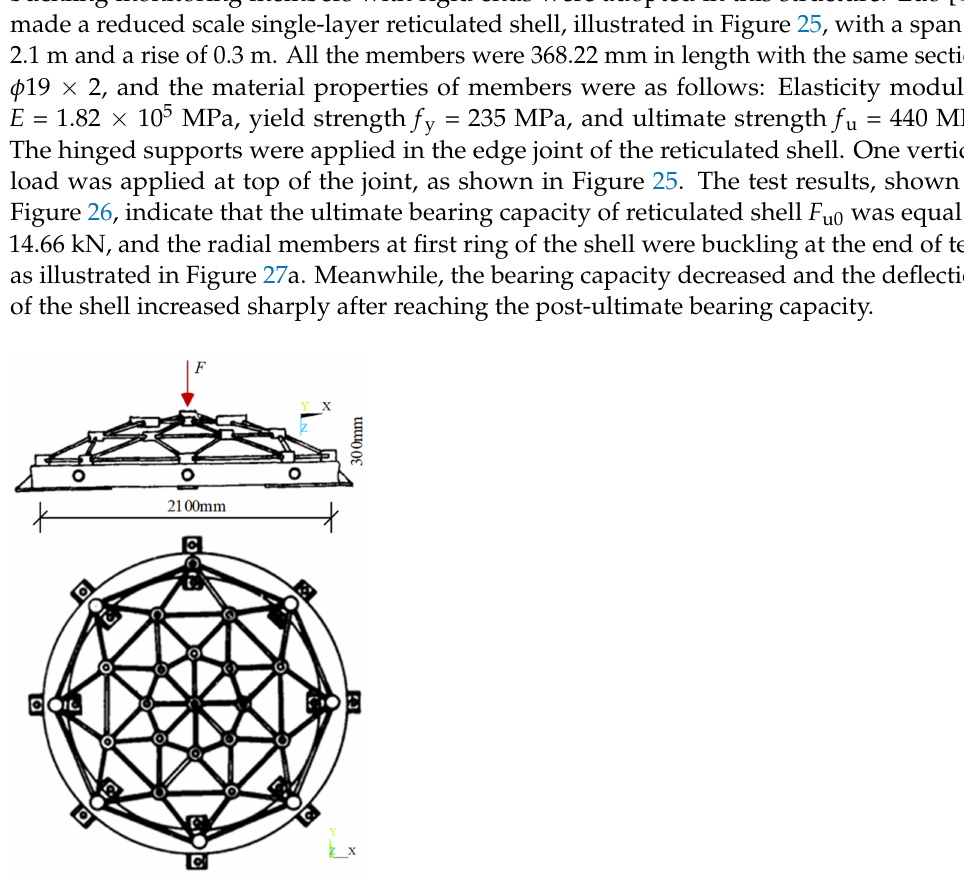
Figure 25. Luo’s static test [40]. (Reprinted with permission from ref. [40], Copyright 1995 Yongfeng